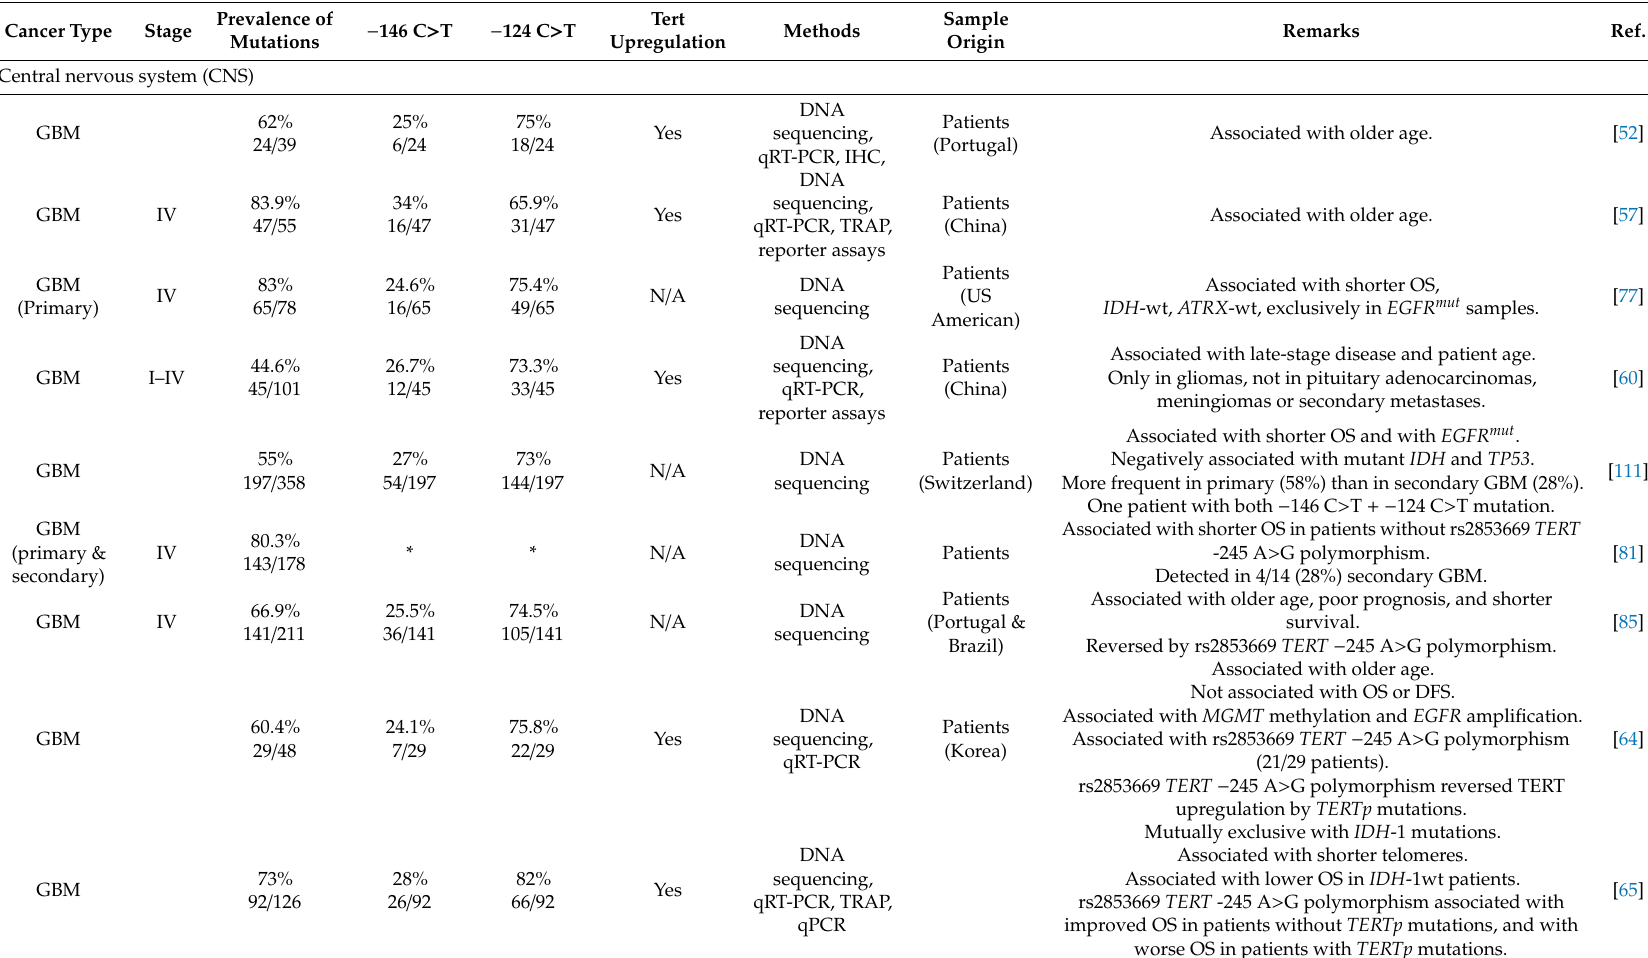
Table 1. Prevalence and distribution of telomerase reverse transcriptase promoter ( TERTp ) mutations in cancer genomes. The prevalence of TERTp mutations is given as percentage and as total number of